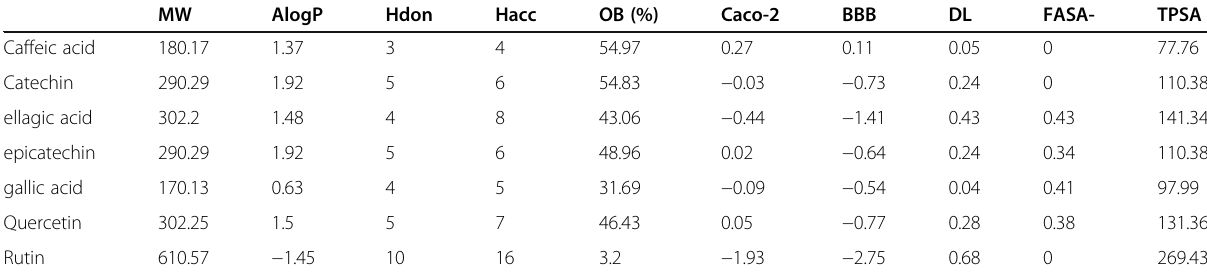
Table 3 Lipinski rule